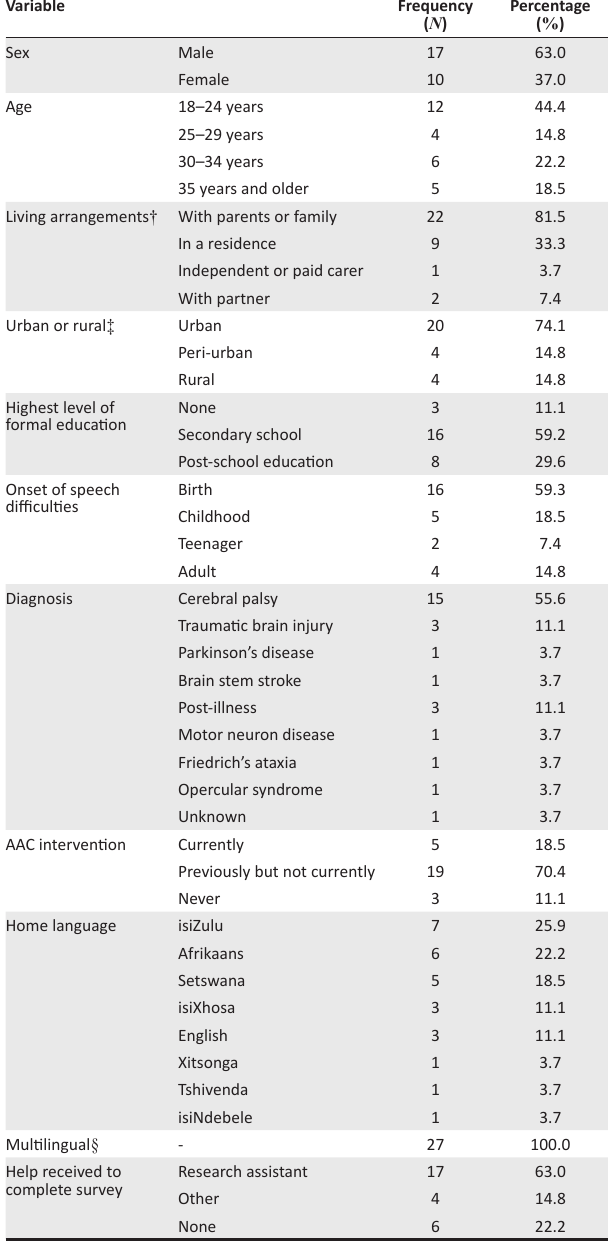
TABLE 1: Participant